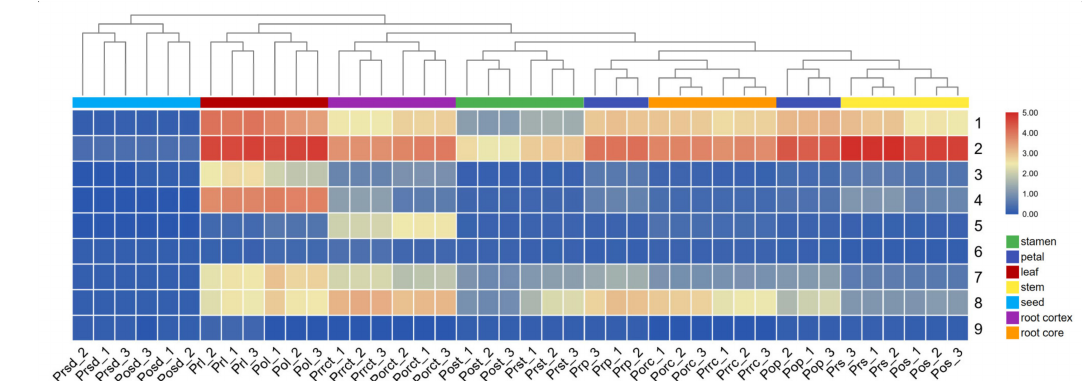
Figure 4. Score plot ( A ) and loading plot ( B ) of principal component analysis of gallotannins in different tissues of P. rockii and P. ostii. .